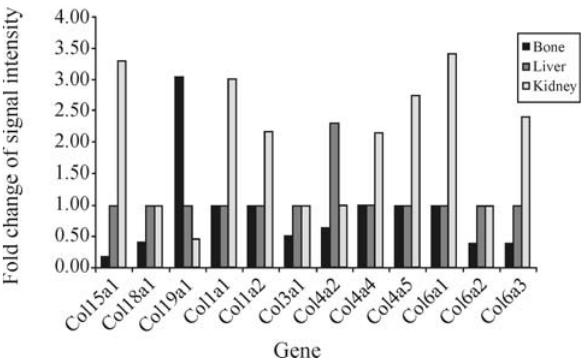
Figure2 -Effectsofascorbicaciddeficiencyoncollagengeneexpression. Distinct effects of ascorbic acid deficiency on the expression of 12 subfamilies of collagen genes were observed in different tissues from mu- tantmice.TheY-barindicatestheratiobetweenthegeneexpressionlevels of sfx and normal mice. The X-bar indicates genes in different tissues. Dif- ferenttissue-specificcollagengenepatternswereobserved.Sevenofthem were upregulated in the kidney, and six were downregulated in the femurs from sfx mice. Only one gene ( Col4a2 ) was found to be upregulated. The expression of almost every gene in the femurs of sfx mice was suppressed, while their expression levels were increased in the